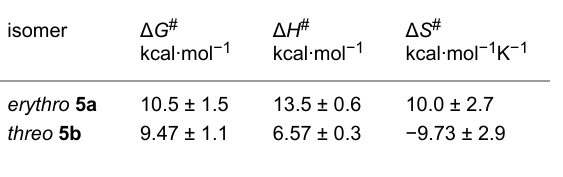
Table 1: The activation parameters of erythro- ( 5a ) and threo- ( 5b ) 1,2-difluorocyclododecanes.